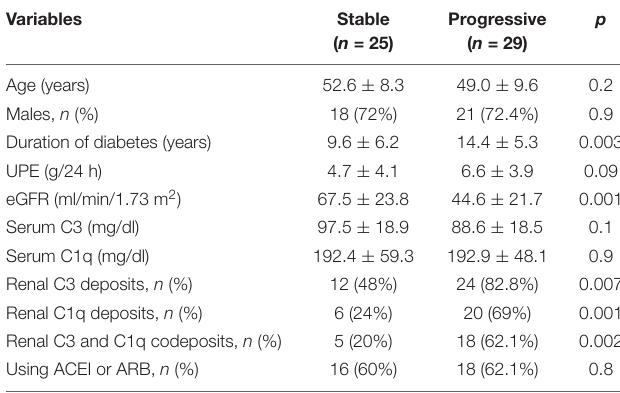
FIGURE 4 | Correlation between mRNA expression of C3 in renal tubulointerstitium and eGFR in patients with diabetic nephropathy. eGFR, estimated glomerular filtration rate.